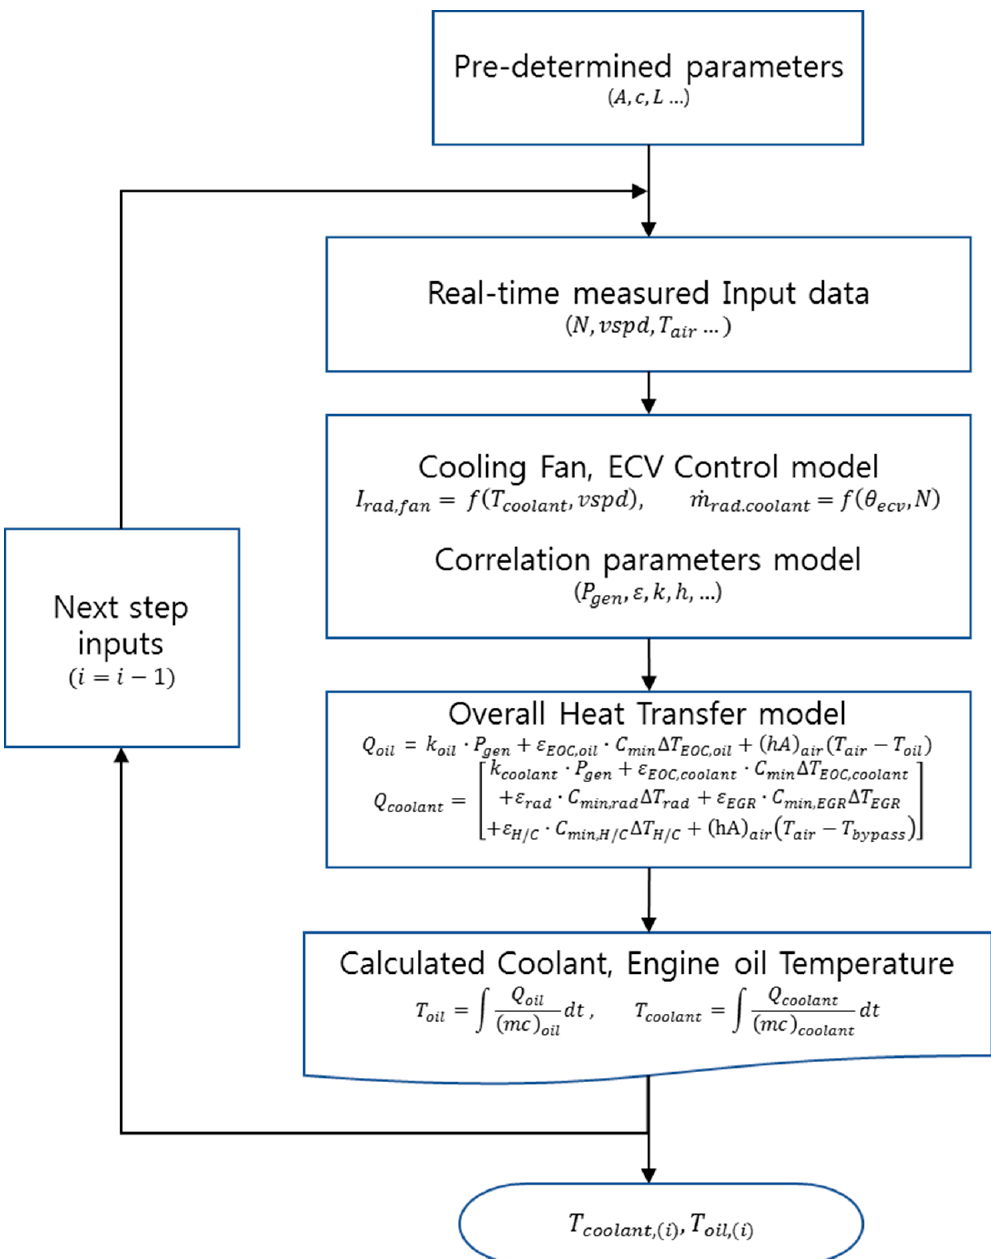
Figure 4. Flowchart of the computational simulation for prediction by physics-based model.